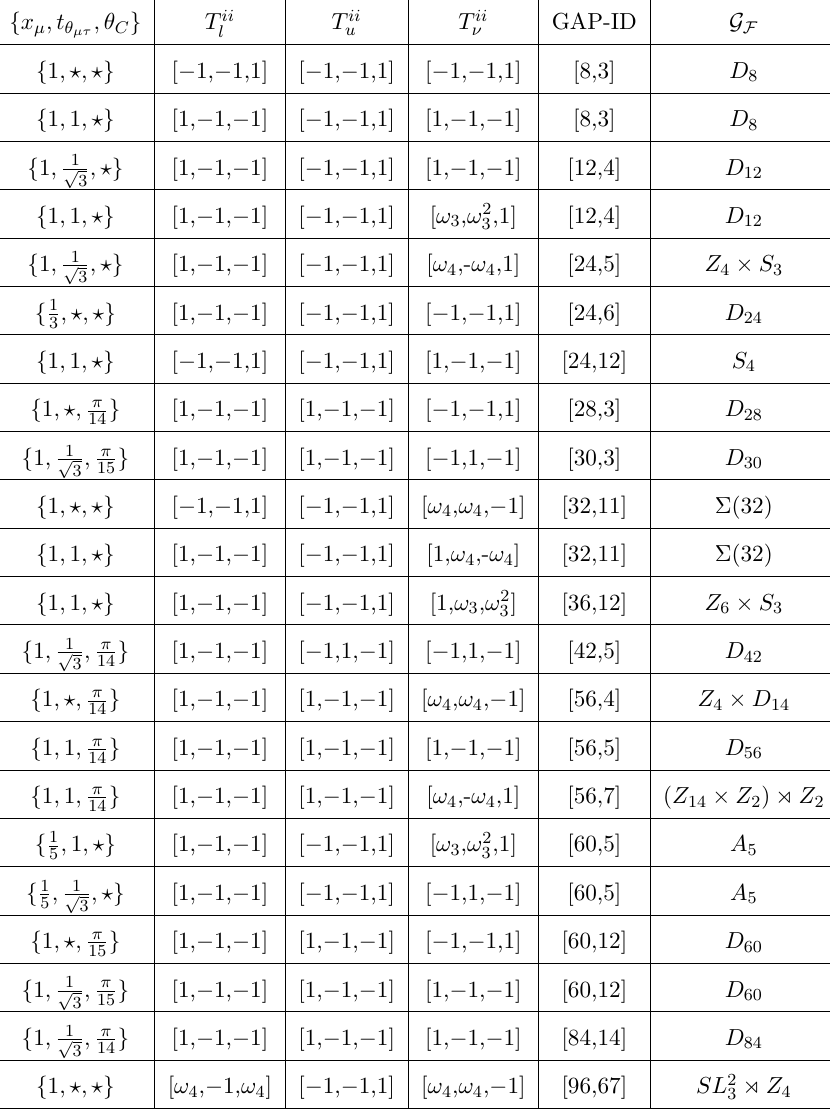
Table 8 . The same as in table 7 but for the muon isolation pattern. Here we only show recon- structed G F , i.e. those groups formed from the closure of all four RFS generators.